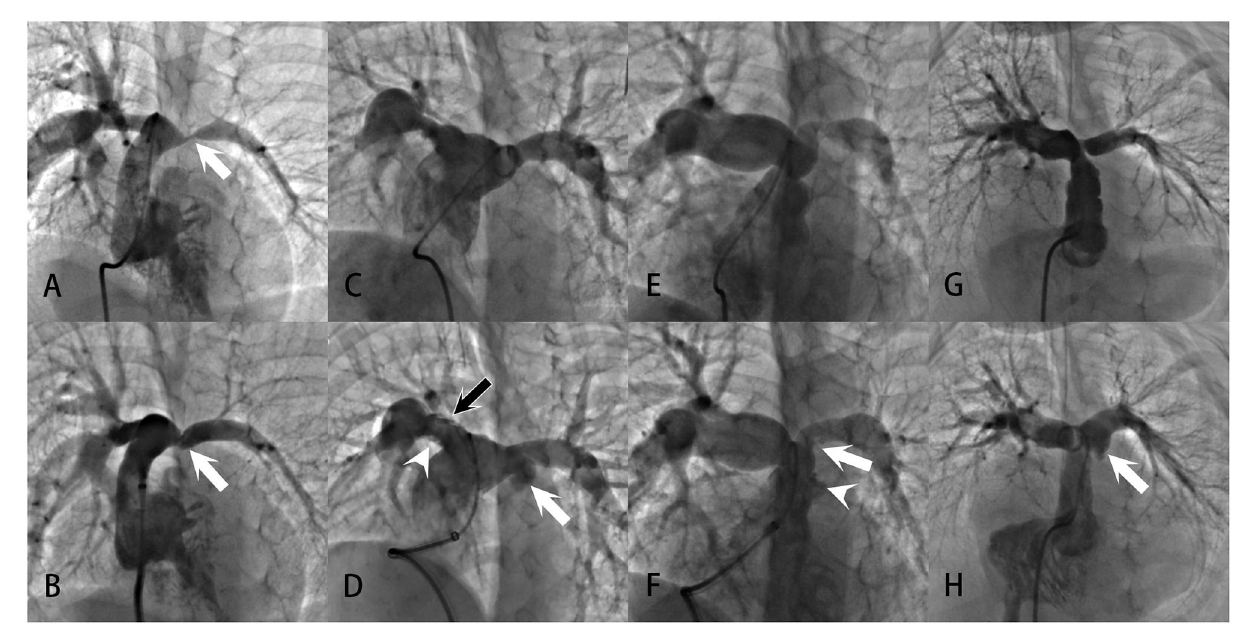
FIGURE2 Examples of pulmonary artery injuries and formation of pulmonary artery aneurysms demonstrated in the angiograms: (A, B) Severe left PAS in a patient with repaired UAPA. After successful angioplasty, the vessel showed intimal irregularities (white arrow), a sign of vessel tear at the intima and media. (C, D) Bilateral branch PASs in a patient with repaired PA/VSD. After angioplasty, intimal irregularities (white arrowhead) and multiple filling defects (black arrow) were present at the upper and lower edge of the right pulmonary artery. Swinging of the filling defects with the cardiac cycle could be seen in the vessel, suggesting the formation of intimal flaps. Vessel extravasation occurred at the left pulmonary artery (white arrow). These were all signs of vessel tears. And the extravasation was large enough to meet the criteria of a pulmonary artery aneurysm. (E, F) Prominent PASs at the main and left pulmonary arteries in a patient with repaired ToF. After angioplasty, there were vessel intimal irregularities and extravasation at the main pulmonary artery (white arrowhead), indicative of vessel tear. An intimal flap was noted at the left pulmonary artery (white arrow). (G, H) Left PAS in a patient with repaired PA/VSD. After angioplasty, localized vessel extravasation and aneurysm formation was noted at the left pulmonary artery (white